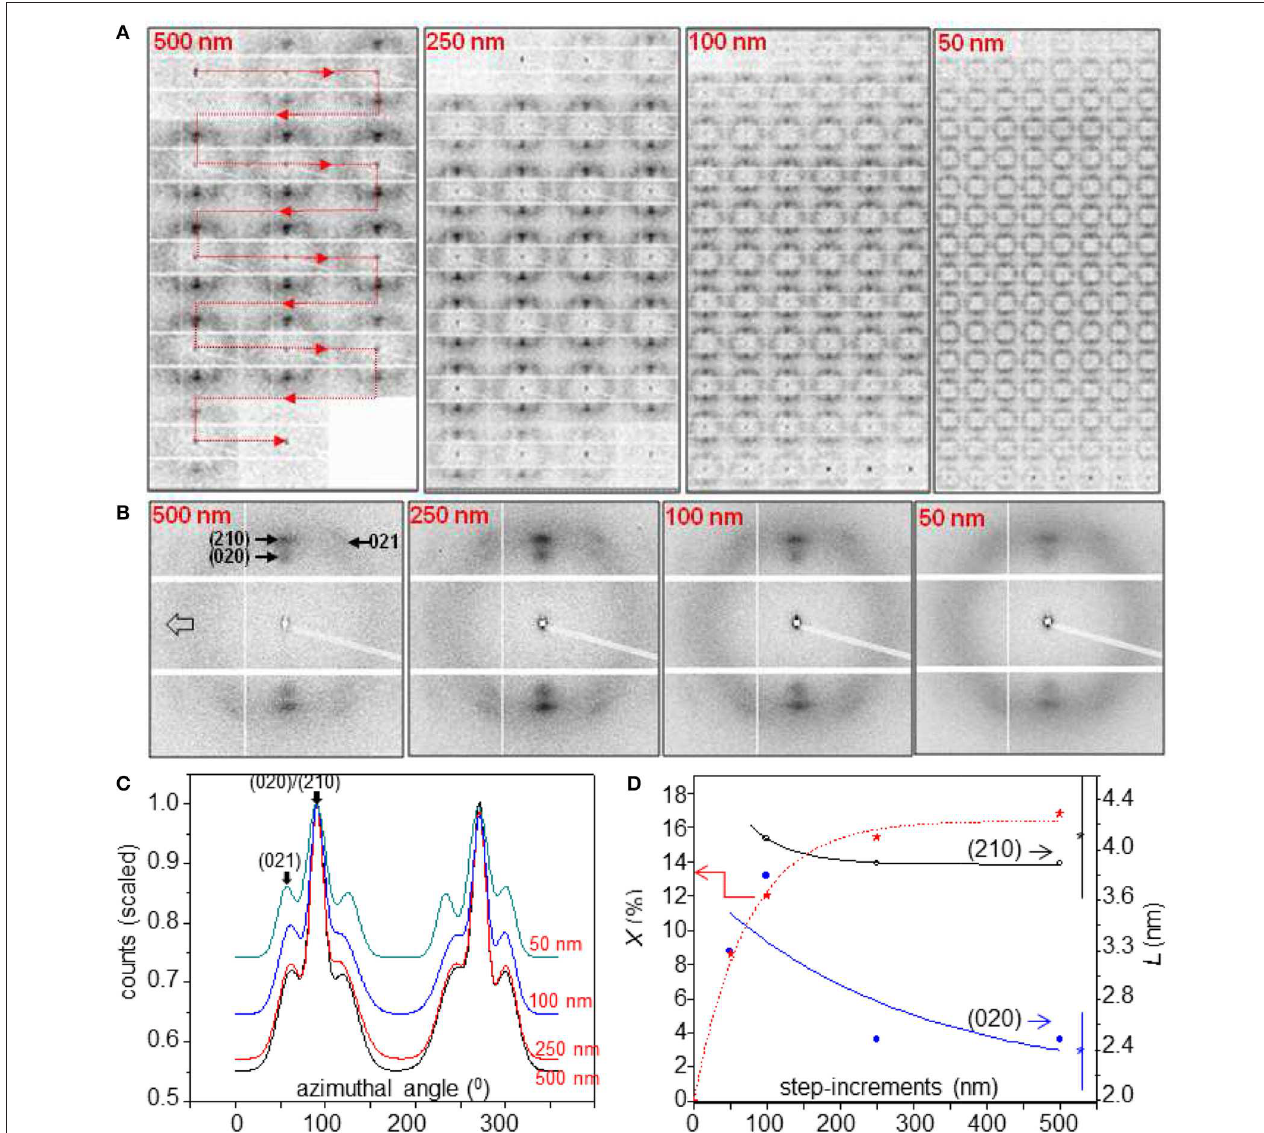
FIGURE 6 | Radiation damage effects during line-scans of A. bruennichi’s MaS fiber through a ∼ 50nm focus. (A) Linear scans normal to fiber axis for step-increments indicated as red insets; 1s exposure per pattern. The red line for 500nm step-increments indicates the succession of patterns in a line-scan across the fiber. (B) Averaged patterns for each line-scan. (C) Radially integrated averaged patterns up to the 1st layer-line scaled to the maximum intensity of the (210) reflections ( = 1.0). (D) Variation of crystallinity ( X ; red stars) and particle size ( L ) for (020) (blue circles) and (210) (black circles) peaks as a function of step-increments. Exponential functions fitted as guides-to-the eye, assuming X = 0% for 0nm focal spot size. L- values with 2 σ error bars to the right were obtained for a 170nm focus (Riekel et al., 2017).